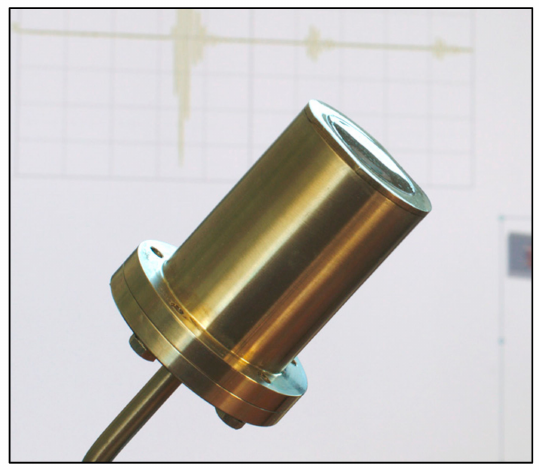
Figure 1. Photograph of a “Transducteur Ultrasonore pour CND Sous Sodium” (TUCSS)